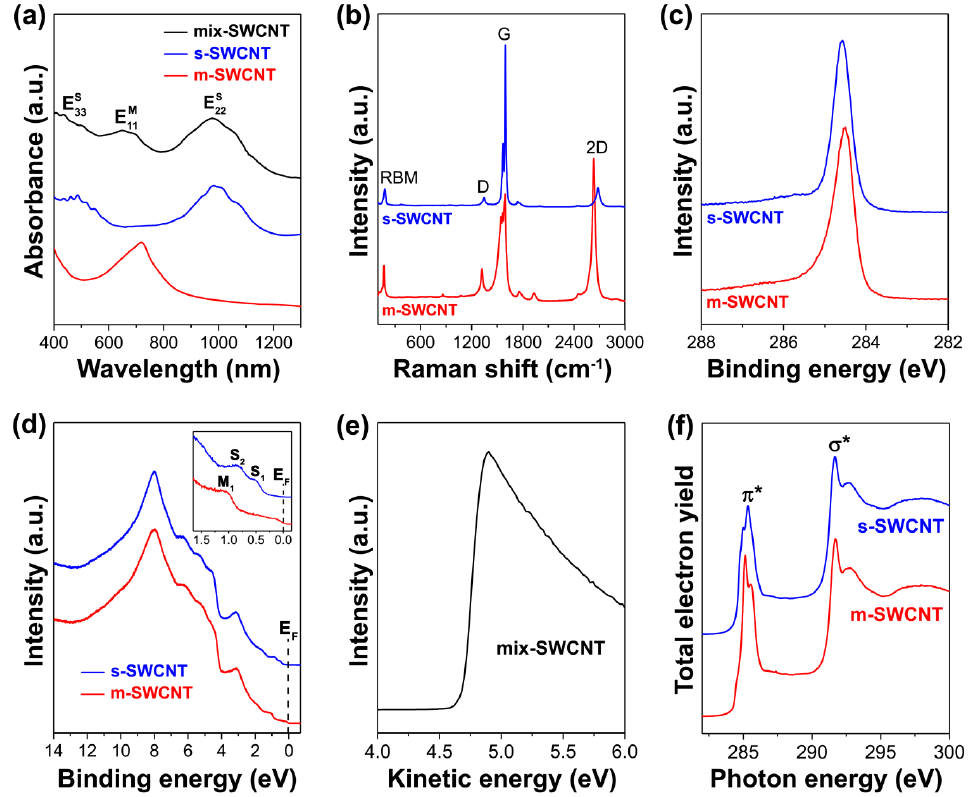
Figure 1. ( a ) The OAS spectra of 1.4 nm-diameter metallicity-mixed (mix-SWCNT) (Reprinted by permission from [13]: SpringerNature, JETP Letters, Kharlamova et al. Study of the electronic struc- ture of single-walled carbon nanotubes filled with cobalt bromide, copyright 2010), semiconducting (s-SWCNT) [25] and metallic SWCNTs (m-SWCNT) [25]. 𝐸 (cid:2870)(cid:2870)(cid:3020) , 𝐸 (cid:2871)(cid:2871)(cid:3020) and 𝐸 (cid:2869)(cid:2869)(cid:3014) denote the peaks that correspond to electronic transitions between the second, the third vHs of semiconducting SWCNTs and the first vHs of metallic SWCNTs. ( b ) The Raman spectra of 1.4 nm-diameter semiconducting [25] and metallic SWCNTs [25] acquired at laser energies of 2.41 eV ( λ ex = 514 nm) and 1.96 eV ( λ ex = 633 nm), respectively. The radial breathing mode (RBM), D, G and 2D-bands of Raman spectra are indicated. ( c ) The C 1s XPS spectra of 1.4 nm-diameter semiconducting [25] and metallic SWCNTs [25]. ( d ) The UPS spectra of 1.4 nm-diameter semiconducting [25] and metallic SWCNTs [25]. The inset zooms in the peaks that originate from the first and the second vHs of semiconducting SWCNTs (S 1 and S 2 , respectively) and the first vHs of metallic SWCNTs (M 1 ). E F denotes the Fermi level of SWCNTs. ( e ) The secondary electrons cutoff spectrum of metallicity-mixed SWCNTs [14]. ( f ) The XAS spectra of 1.4 nm-diameter semiconducting [26] and metallic SWCNTs [26].Copyright 2009, American Physical Society. The π *- and σ *- resonances are indicated. 2.1.2. Signatures of Doping-Induced Modifications of the OAS Spectra of SWCNTs Upon filling-induced doping of SWCNTs, their OAS spectrum can undergo suppres- sion of the characteristic peaks (Table 1). This is due to the depletion of optical transitions between the vHs in the valence band and conduction band of SWCNTs, because of emp- tying the vHs in the valence band or occupying the vHs in the conduction band (Figure 2) [14]. This effect is caused by the charge transfer-induced down- or upshift of the Fermi level of SWCNTs, respectively, i.e., p -type or n -type doping of SWCNTs [10]. However, the type of doping could not be identified from the OAS data. Table 1. Summary of doping-induced modifications of the OAS spectra of filled SWCNTs. Filled Substance